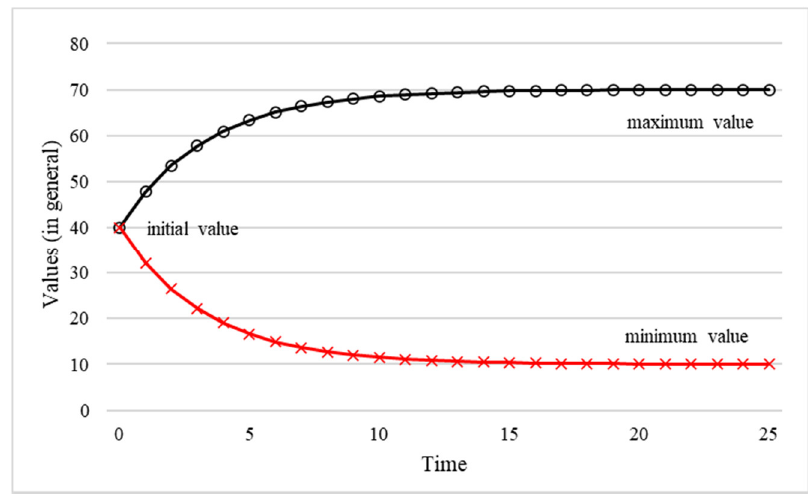
Figure 10. General exponential decay/growth curves.